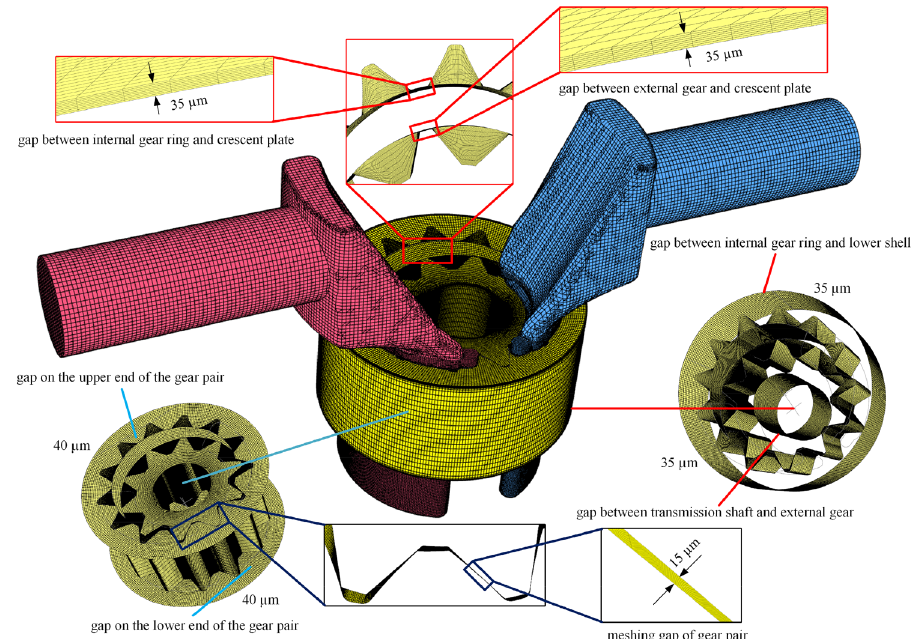
Figure 10. Grid model of Truninger